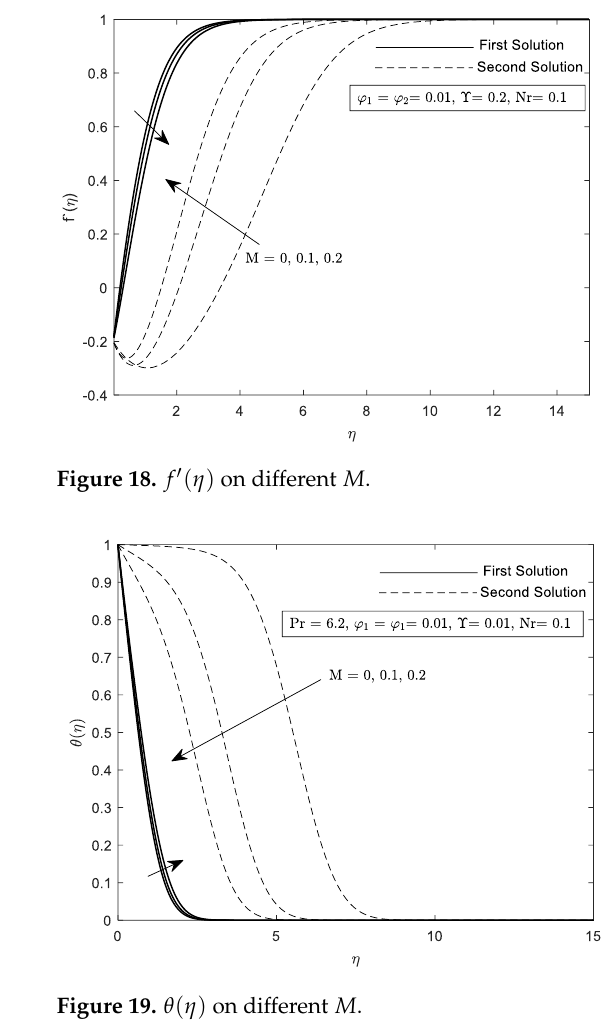
1 1 2 for several Nr with ϕ 1 = ϕ 2 . Figure 17. 𝑁𝑢 − 1 2 for several Nr with 𝜑 1 = 𝜑 2 . 1 2 for several Nr with 𝜑 1 = 𝜑 2 . 𝒙 (𝑅𝑒 𝒙 ) 2 for several Nr with 𝜑 1 = 𝜑 2 .